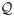
Locus of the trendline parameters (a, b) in the Cartesian plane, Q, for the determinants Ti,j(t), Si,j(t), Zi,j(t) and Wi,j(t), and the 11 countries analyzed, t ∈ [1960, 2015].The diameter and color of the circles are proportional to the value of R2. The dashed line delimits 2 clusters.